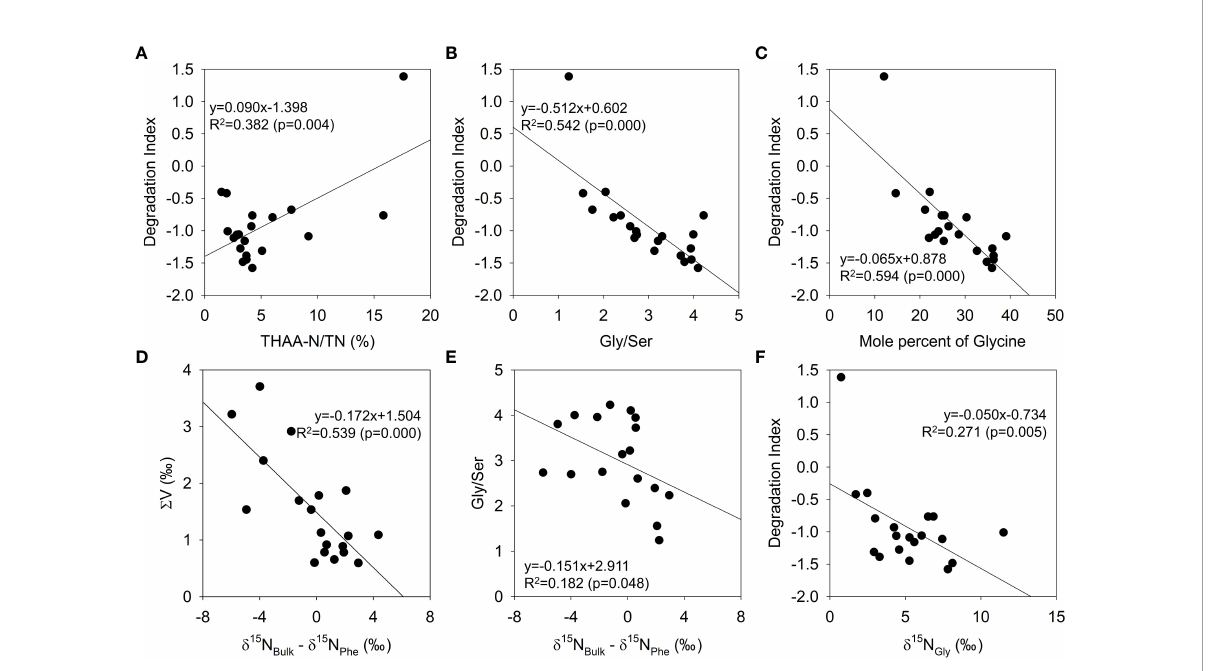
FIGURE 7 Regressions among diagenetic indicators estimated from core and surface sediment. THAA-N/TN versus DI (A) , Gly/Ser versus DI (B) , mole percent of Gly versus DI (C) , d 15 N Bulk - d 15 N Phe versus S V (D) , d 15 N Bulk - d 15 N Phe versus Gly/Ser (E) , and d 15 N Gly versus DI (F)